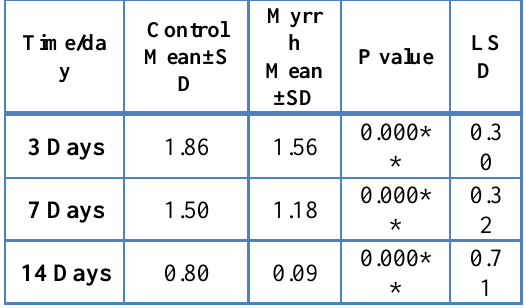
Table 2: Descriptive statistics of inflammatory cells account in each period